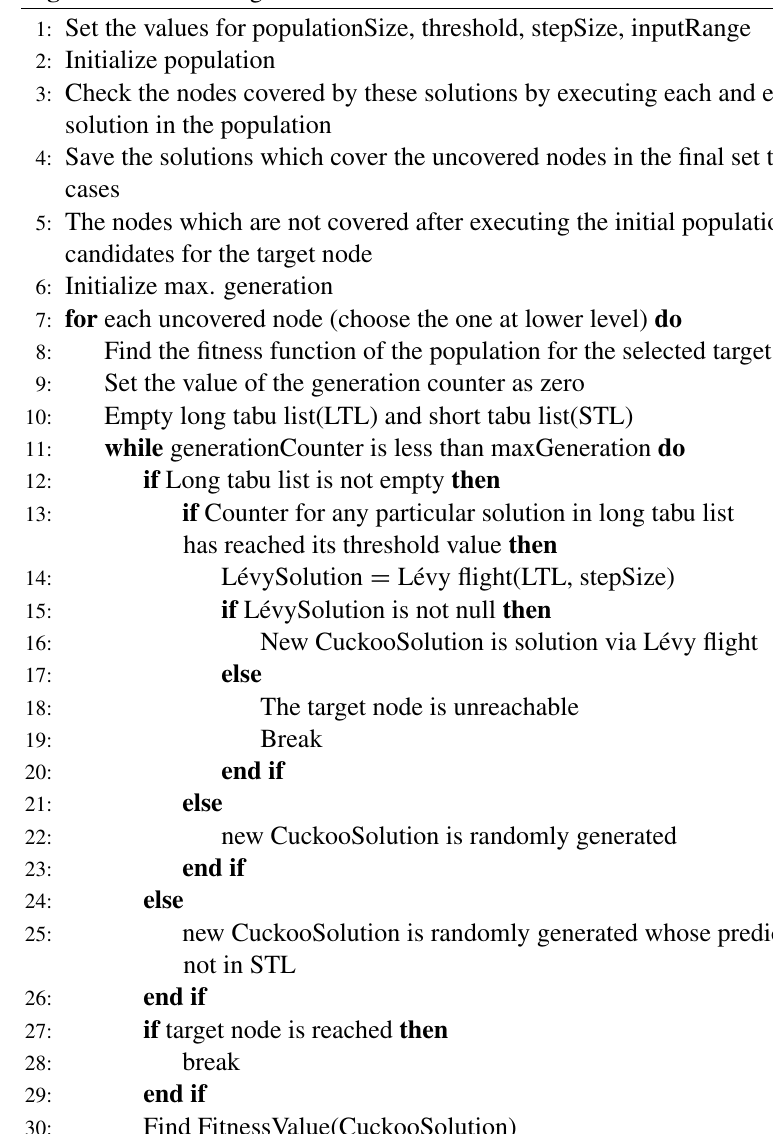
Algorithm 1 Main